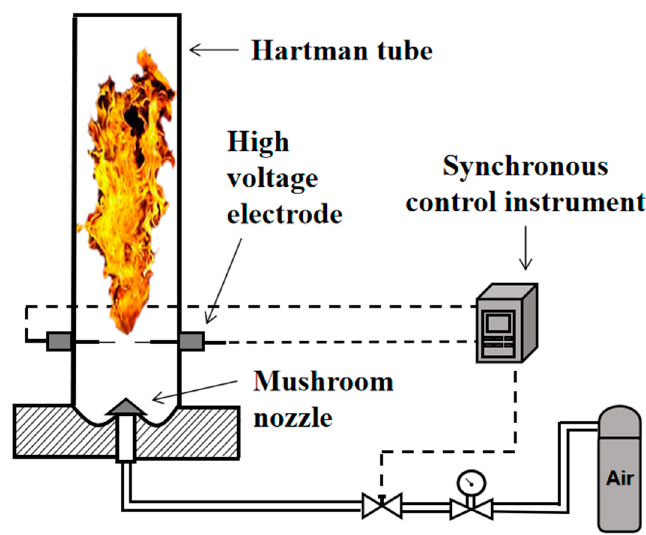
Figure 2. Experimental apparatus for the minimum ignition energy (MIE) test.